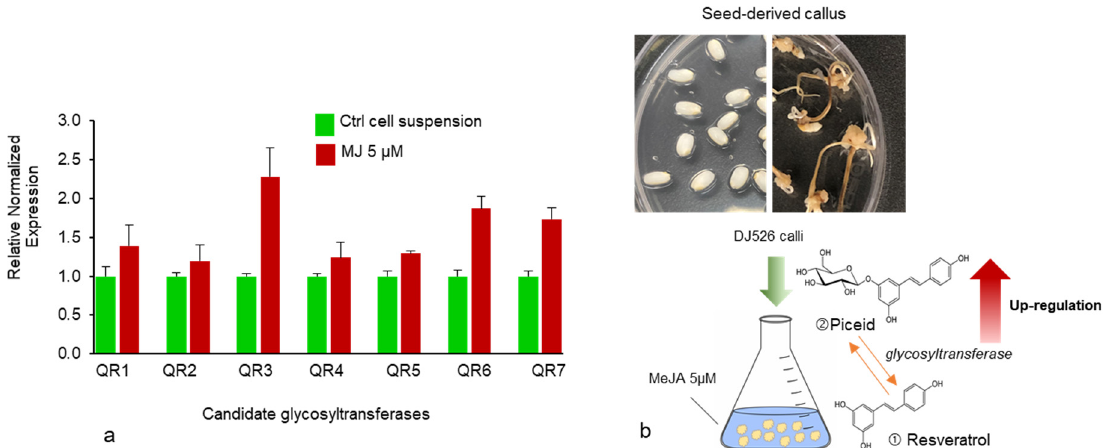
Figure 6. ( a ) Relative normalized expression of candidate UDP-glycosyltransferase genes after 5 µ M MeJA treatment compared with the control group. Expressions are presented as means ± SEM. ( b ) Schematic representation of in vitro DJ526 cell suspension culture. Calli were induced on 2,4-D supplement media and the suspension culture was treated with 5 µ M MeJA, which led to an increase in glycosyltransferase activity.